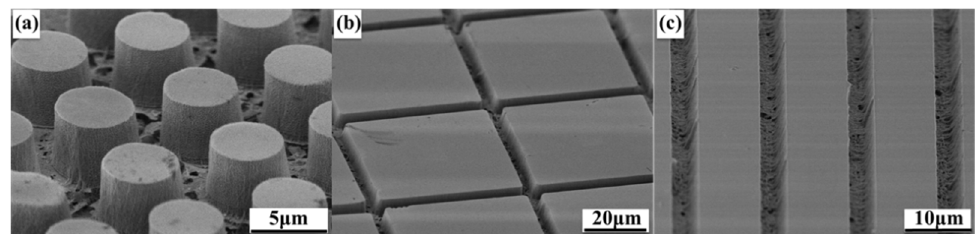
Figure 3. Cross-sectional SEM images (45 ◦ -tilt view) of the etched GaN microstructures with different shapes: ( a ) micropil-